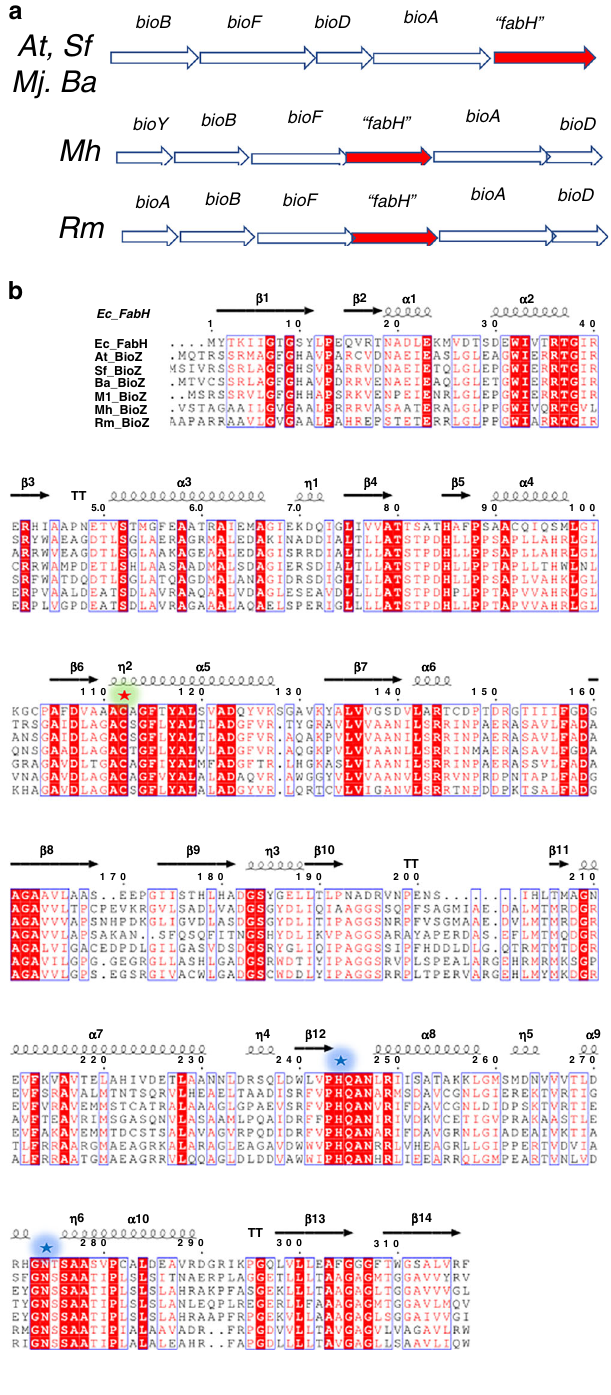
Fig. 2 Biotin synthesis gene clusters containing putative bioZ genes and alignment of BioZ proteins with E. coli FabH. a The annotated biotin gene clusters of four species of α -proteobacteria are shown where “ fabH ” is bioZ . At is Agrobacterium tumefaciens , a plant pathogen; Sf is Sinorhizobium fredii , a plant symbiont; Mj is Mesorhizobium japonicum (Mj),